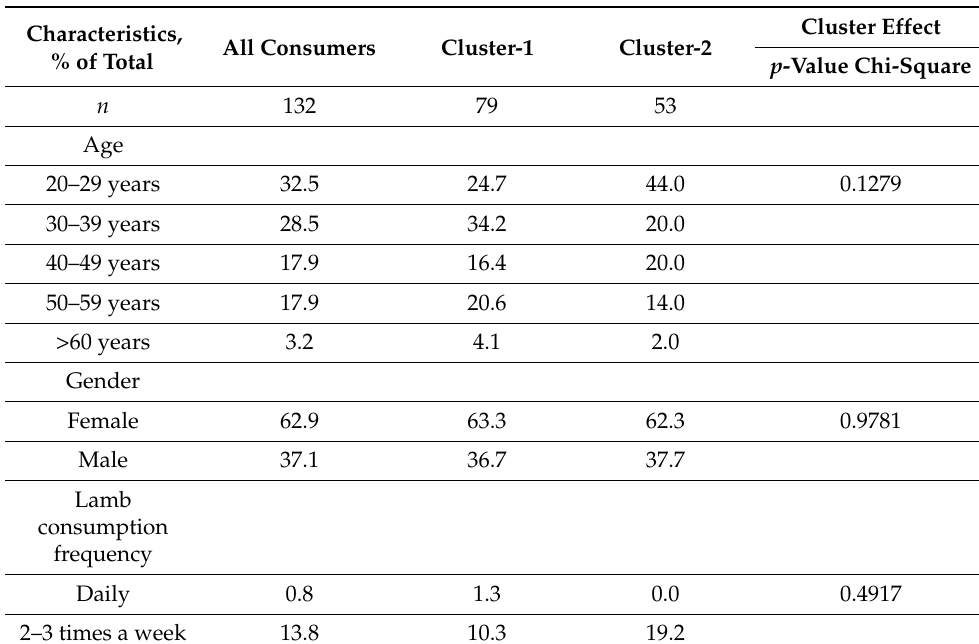
Table 1. Socio-demographic characteristics for all consumers and their clusters.